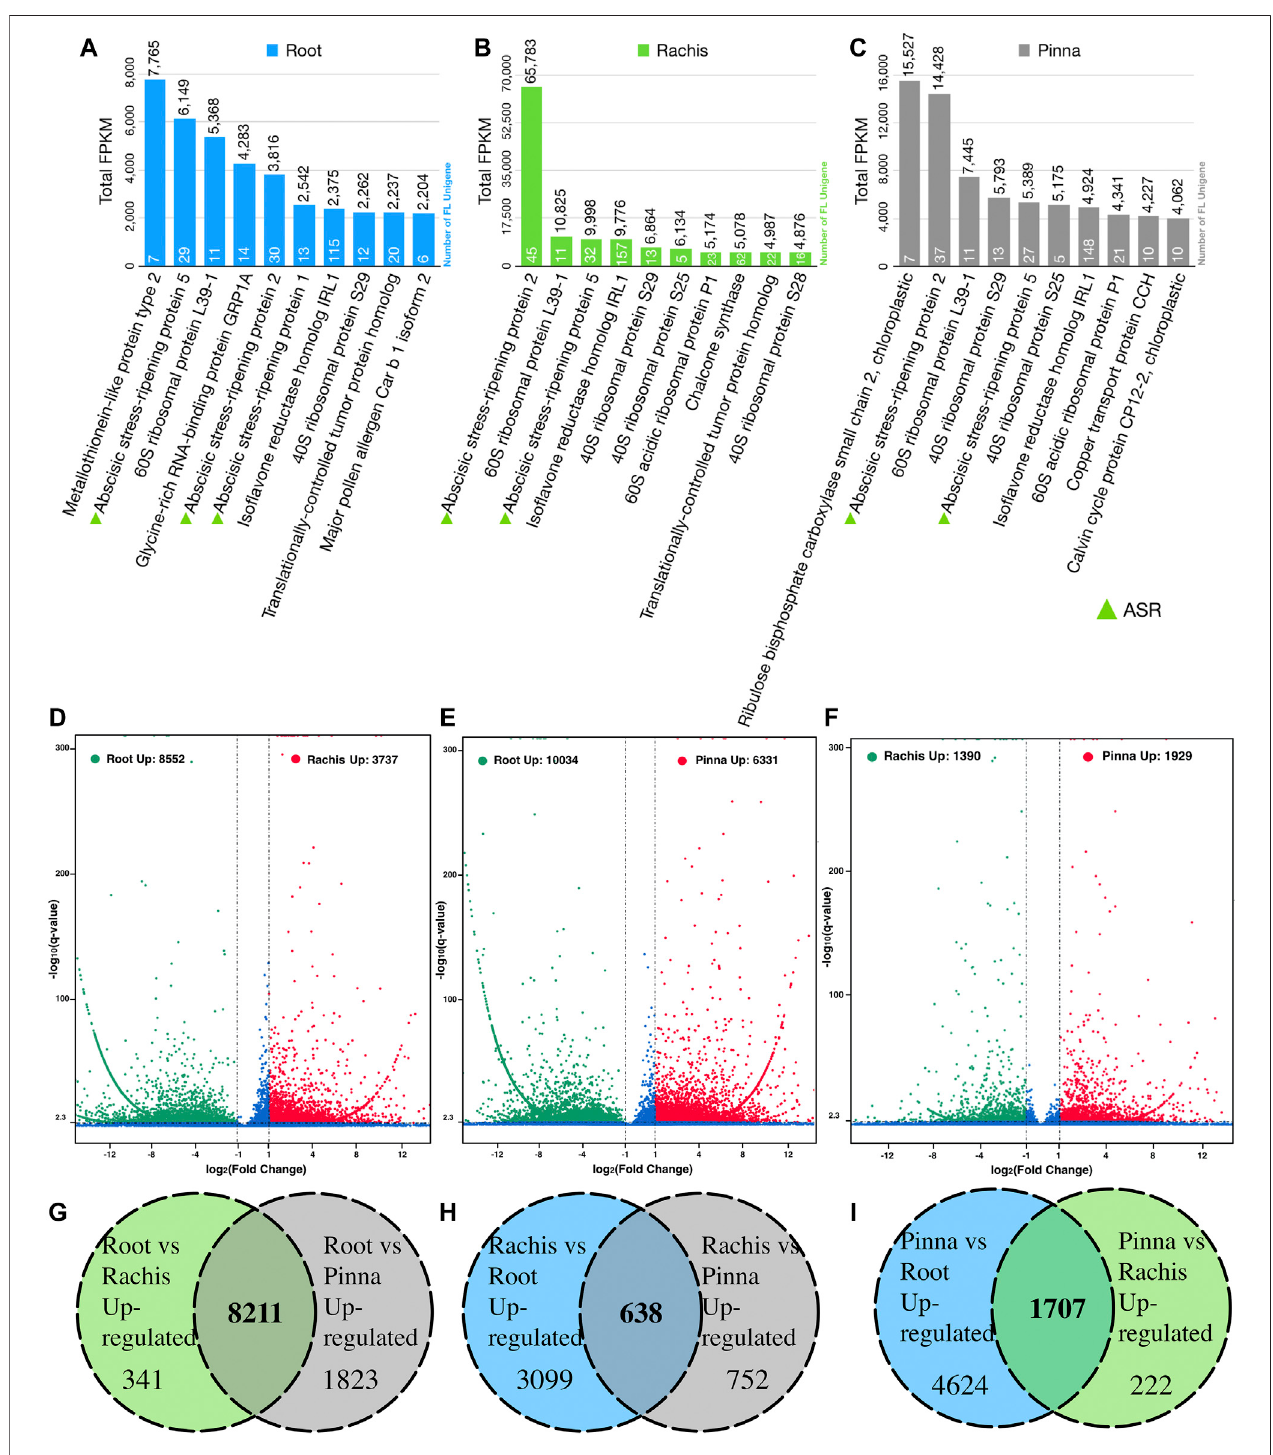
FIGURE3| Thetopexpressed genesinthree organsbased onSwiss-Prot database annotationand pairwisedifferentialexpression geneanalysis. (A) Thetopten expressed genes inroot. (B) Thetop ten expressed genesin rachis. (C) The top tenexpressed genes inpinna. (D) Rachisversusroot differentially expressed genes. (E) Pinna versus root differentially expressed genes. (F) Pinna versus rachis differentially expressed genes. (G) Number of root upregulated genes versus rachis and pinna. (H) Number of rachis upregulated genes versus root and pinna. (I) Number of pinna upregulated genes versus root and rachis.